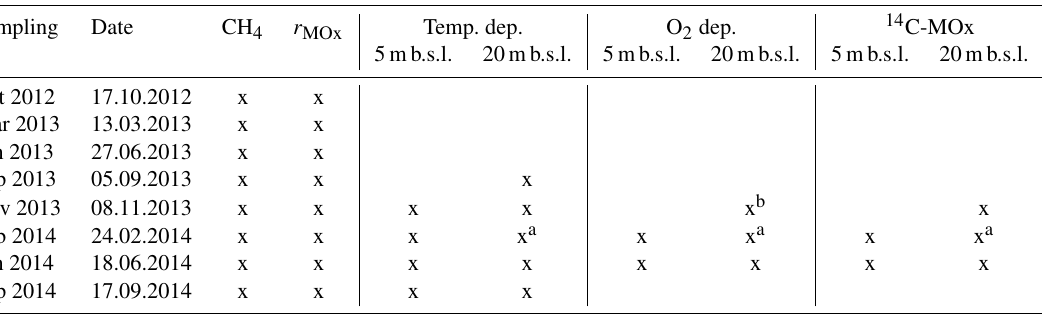
Figure 2. Seasonal variability of physico-chemical parameters and aerobic methanotrophy at the Boknis Eck station. Distribution of salin- ity (a) , oxygen (b) , temperature (c) , methane (d) , first-order rate constants of aerobic methane oxidation k (e) , and aerobic methane oxidation rates r MOx (f) . Positions of discrete samples (dots) and continuous measurements (dashed lines) are indicated. Depths of water used for oxygen and temperature incubation experiments (Figs. 3 and 5) are indicated with circles in (b) and (c) . Depths of water used for biomass incorporation experiments at different oxygen concentrations (Figs. 4, S2) are indicated with crosses in (b) . Table 1. Overview of sampling dates and sampled parameters. “Temp. dep.” indicates samples used for temperature dependency incubations, “O 2 dep.” indicates samples used for O 2 incubations with 3 H-CH 4 and 14 C-MOx for O 2 incubations with 14 C-CH 4 and determination of 14 C-incorporation into